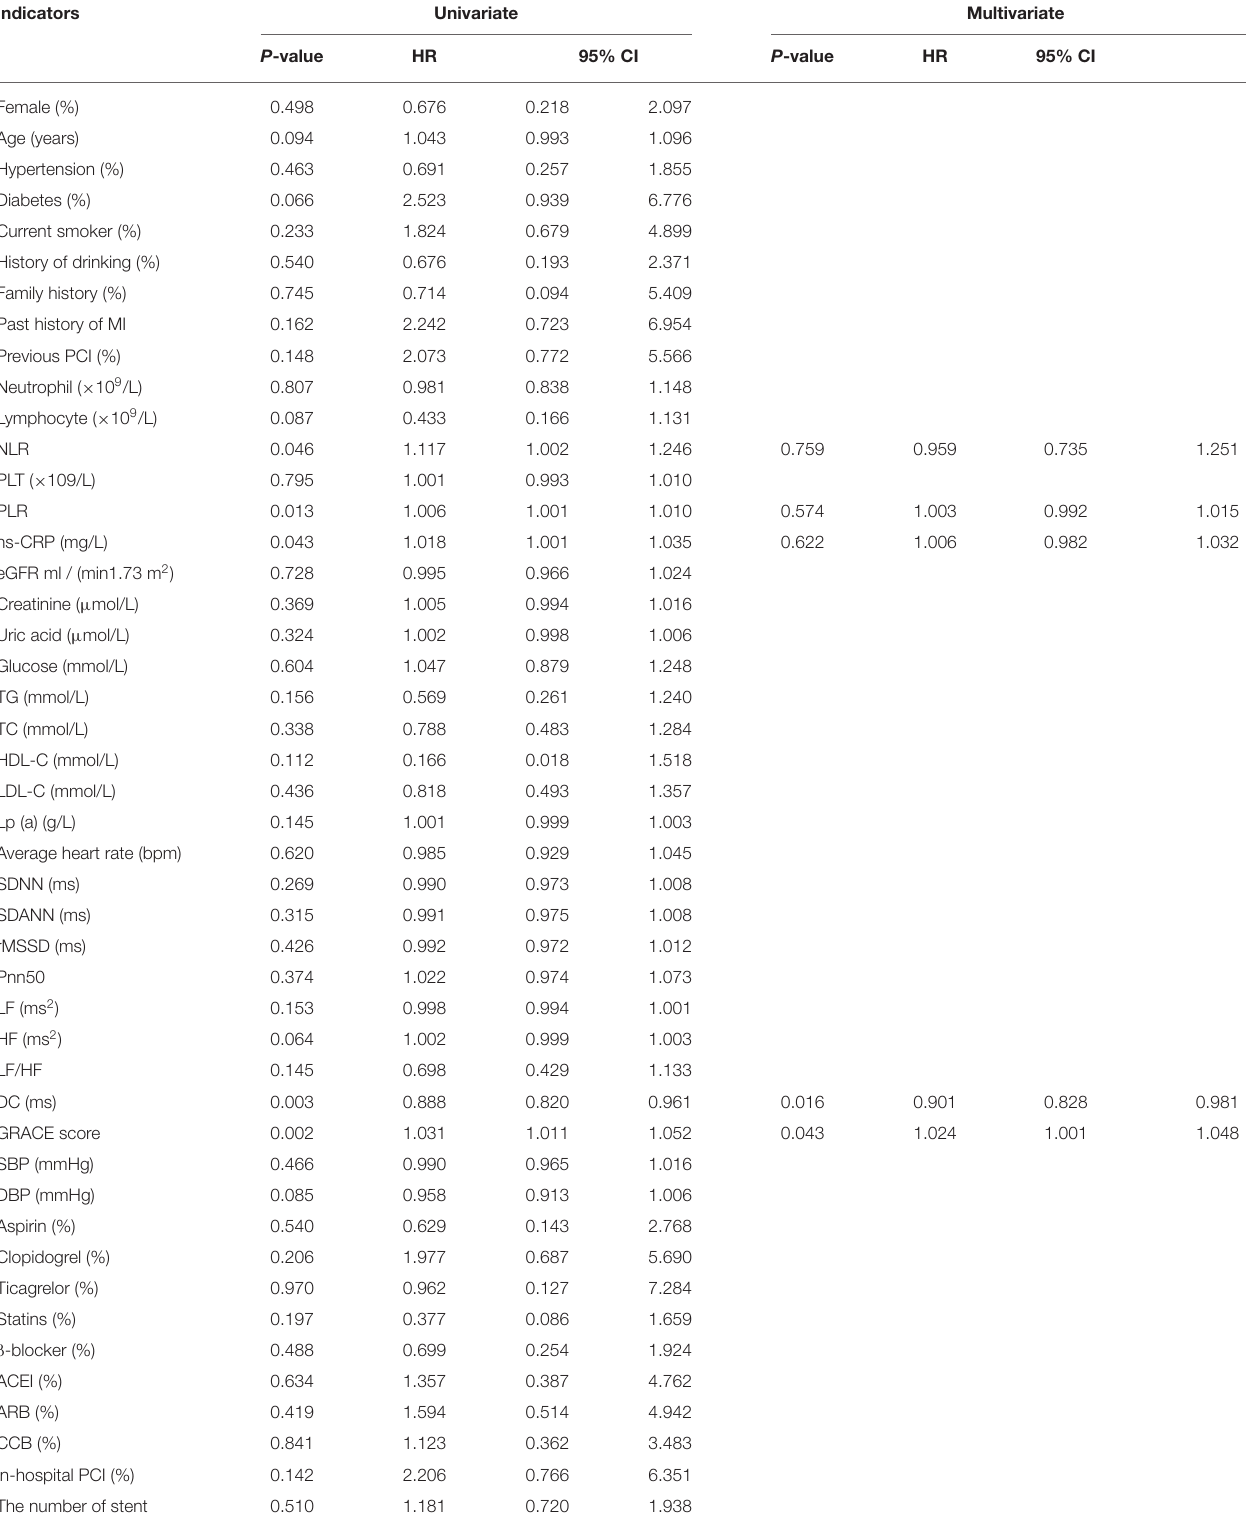
TABLE 3 | Predictors of the occurrence of MACEs in patients with ST- segment Elevation Myocardial Infarction (STEMI): results of univariate and multivariate Cox-regression analyses. Indicators Univariate